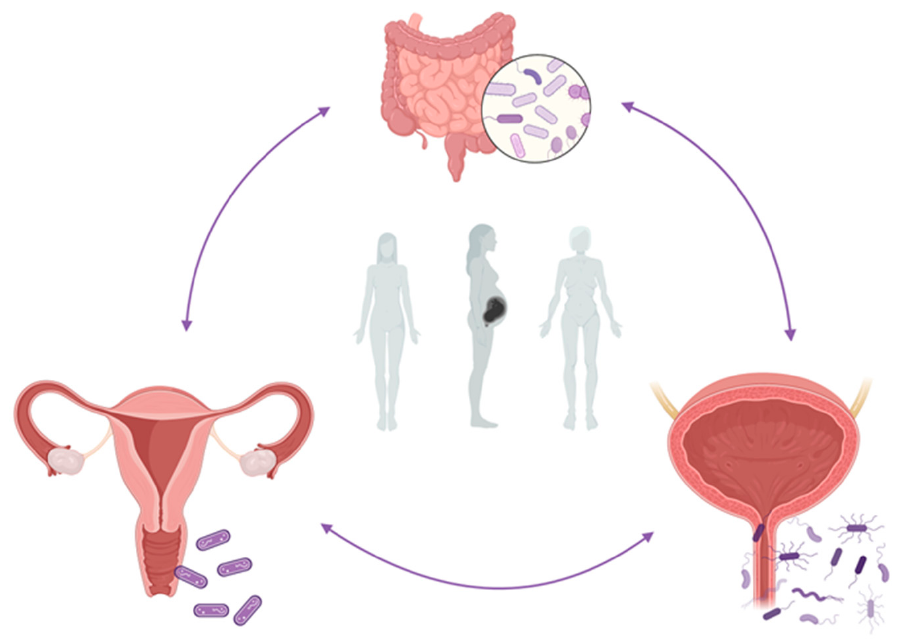
Figure 1. Abstract figure. The interplay between the gut, vaginal, and urinary microbiome in the onset of rUTIs during woman different ages. Figure created with BioRender.com (accessed on 29 January 2023).